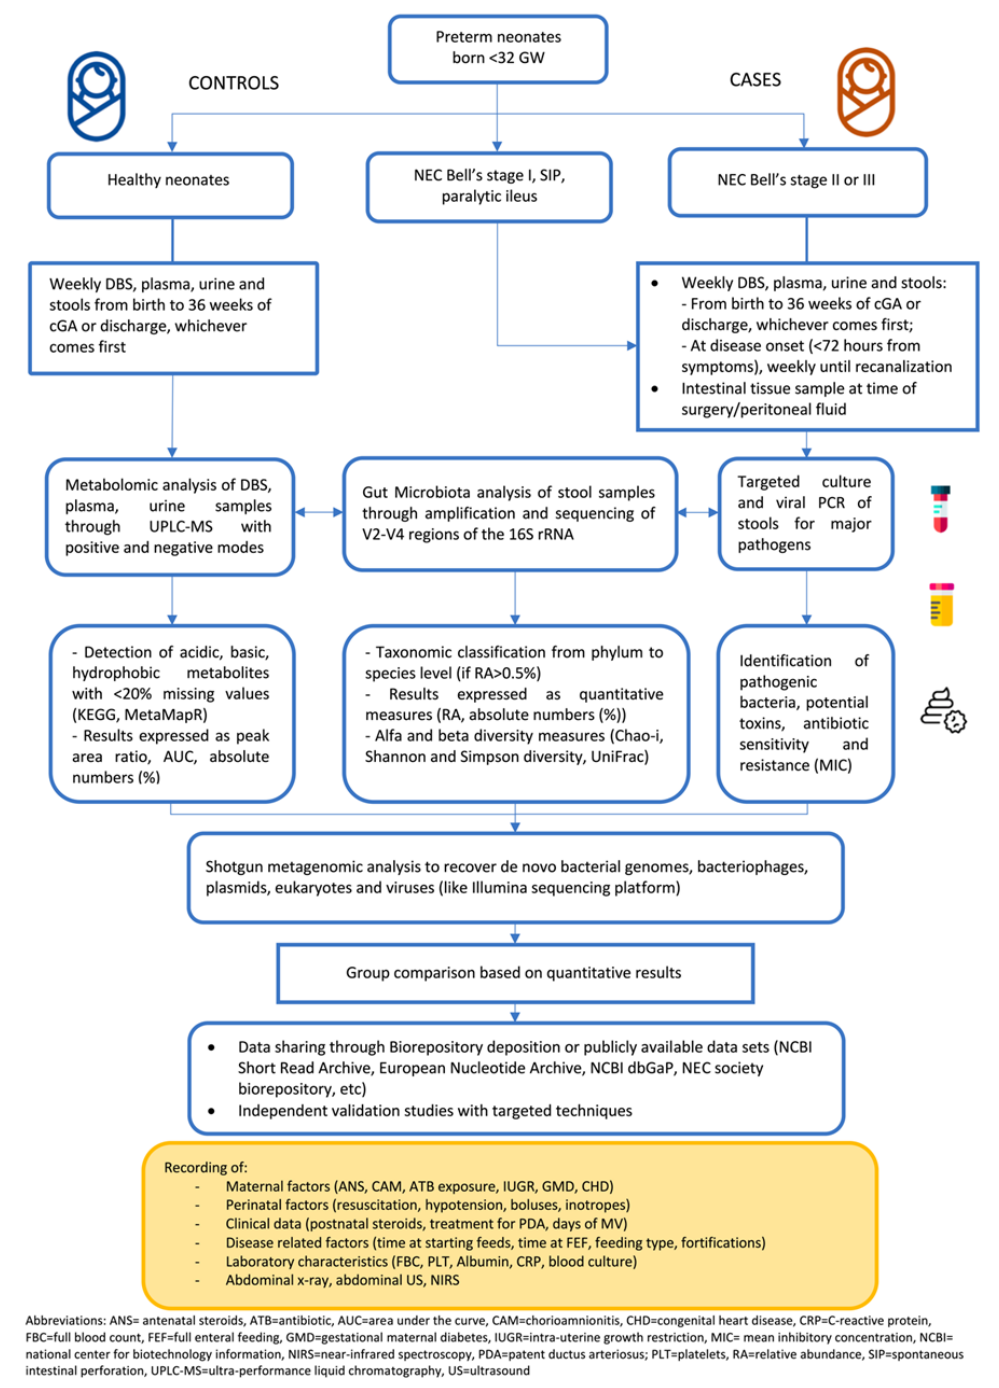
Figure 3. Proposed flow chart to conduct future studies applying untargeted metabolomics and microbiota analysis in the exploration of biomarkers for NEC.